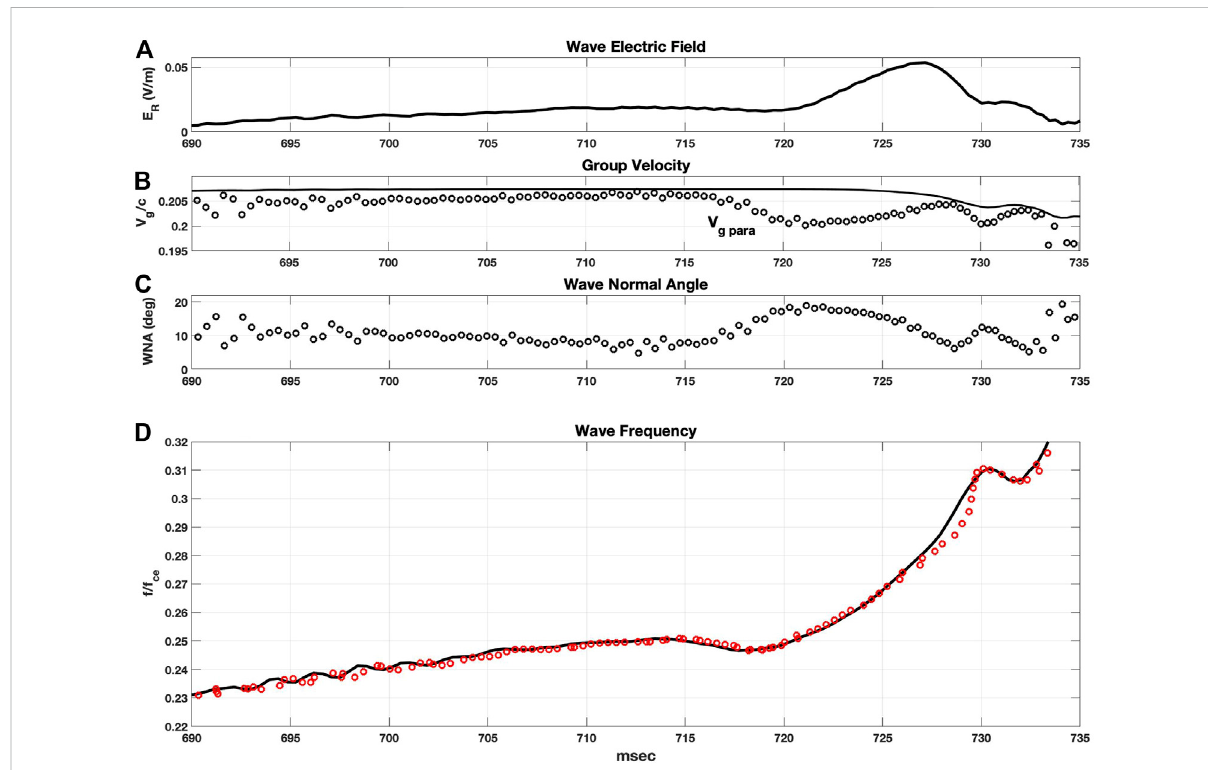
FIGURE 7 Wave parameters evaluated at each 1/2 wave cycle for a chorus wave element observed during the 17 March 2013 event at 16:39:07 UT are shown in black. (A) Wave electric fi eld (E R ) shows an initial weak subpacket (690 – 720 msec) ans a strong (50 mV/m) second subpacket (720 – 730 msec). (B) Wave group velocity is shown by the solid curve while the parallel group velocity, including the effects of varying wave normal angle, is shown as circles. (C) Low wave normal angle ( < 20 deg) is observed through both subpackets with signi fi cant variation across the secondsubpacket. (D) Thefrequencysweeprateobservedattheoff-equatoriallocationisshownasthesolidblackcurve.Backprojection3,000 km toward the equator using the observed values of V g para estimates the chorus sweep rate pro fi le at the equator (red circles, shifted forward in time 50 msec for comparison with the observed pro fi